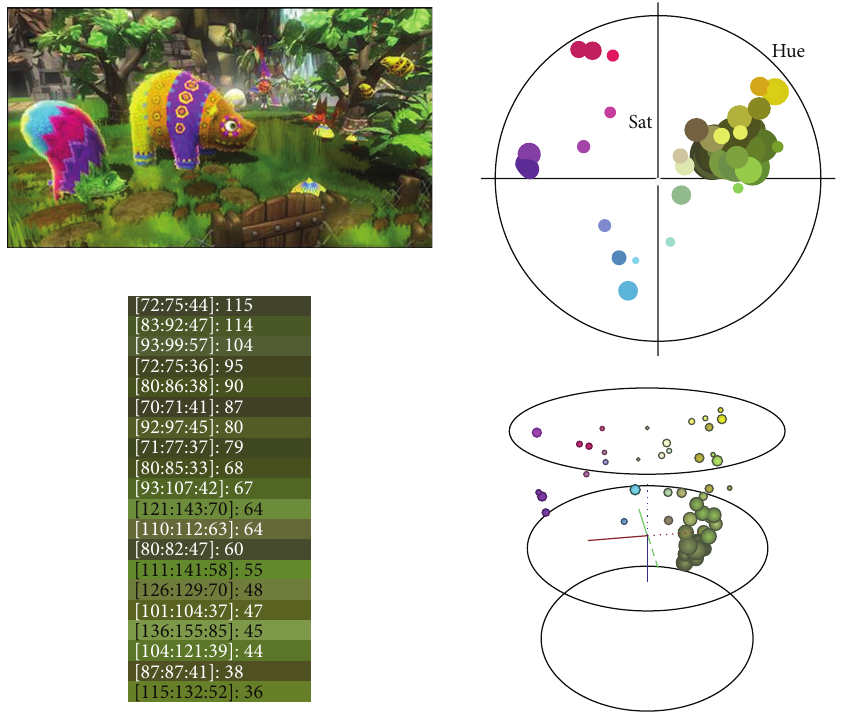
Figure 3: Video games frame colors second analysis.